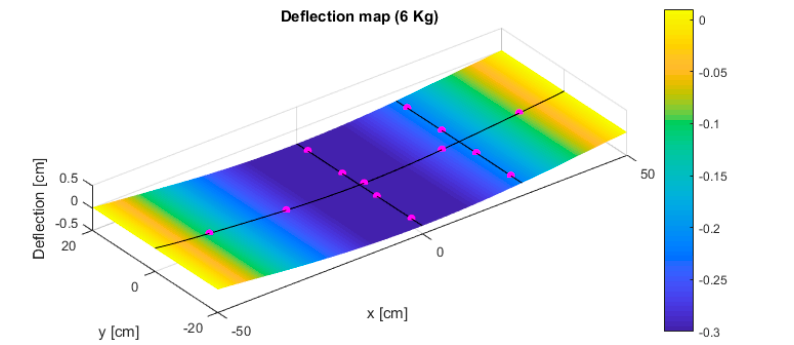
Figure 4. Deflection map of the multilayer panel with a load of 6